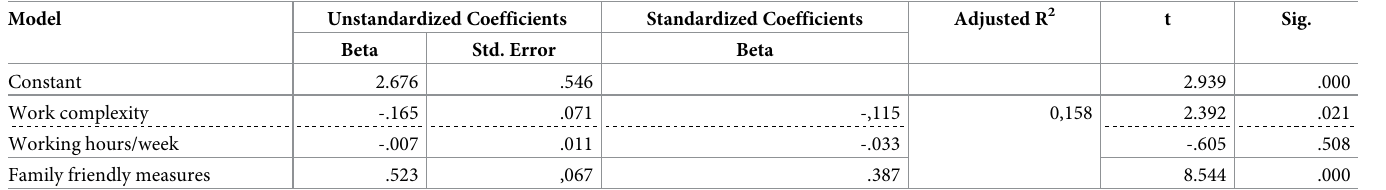
Table 2. Estimation of regression coefficients of work complexity, number of working hours per week, and family-friendly policies and practices, and work-family balance.